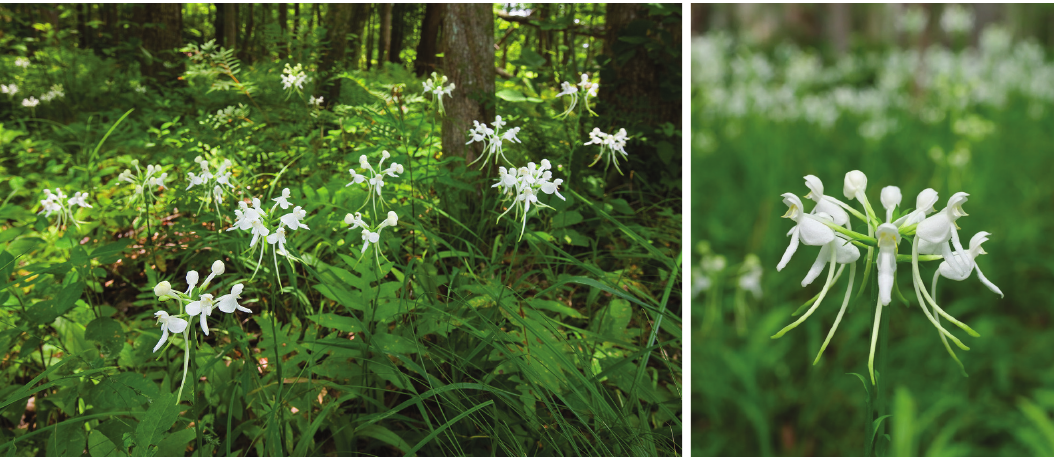
Figure 1. Occurrence of the terrestrial orchid Platanthera integrilabia in an acidic swamp in Tennessee, USA ( left ) and an inflorescence of the white fringeless flowers that distinguish this species from others in the genus ( right